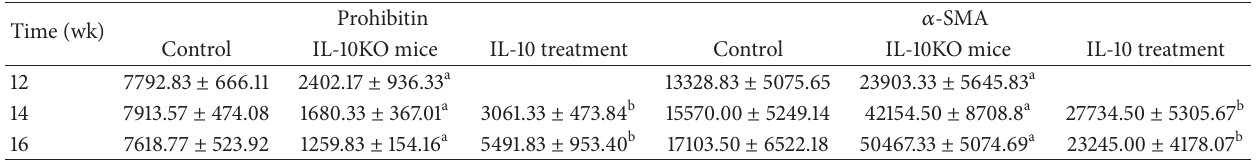
Table 3: Protein expression of prohibitin and 𝛼 -SMA ( 𝑥 ± 𝑠 ).